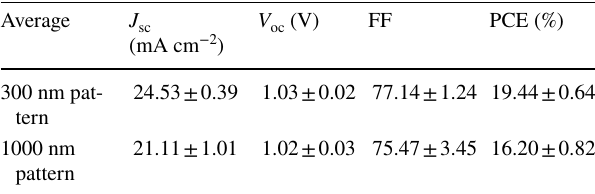
Table 1 Average performance values from 20 PSCs with and with‑ out moth‑eye PDMS films